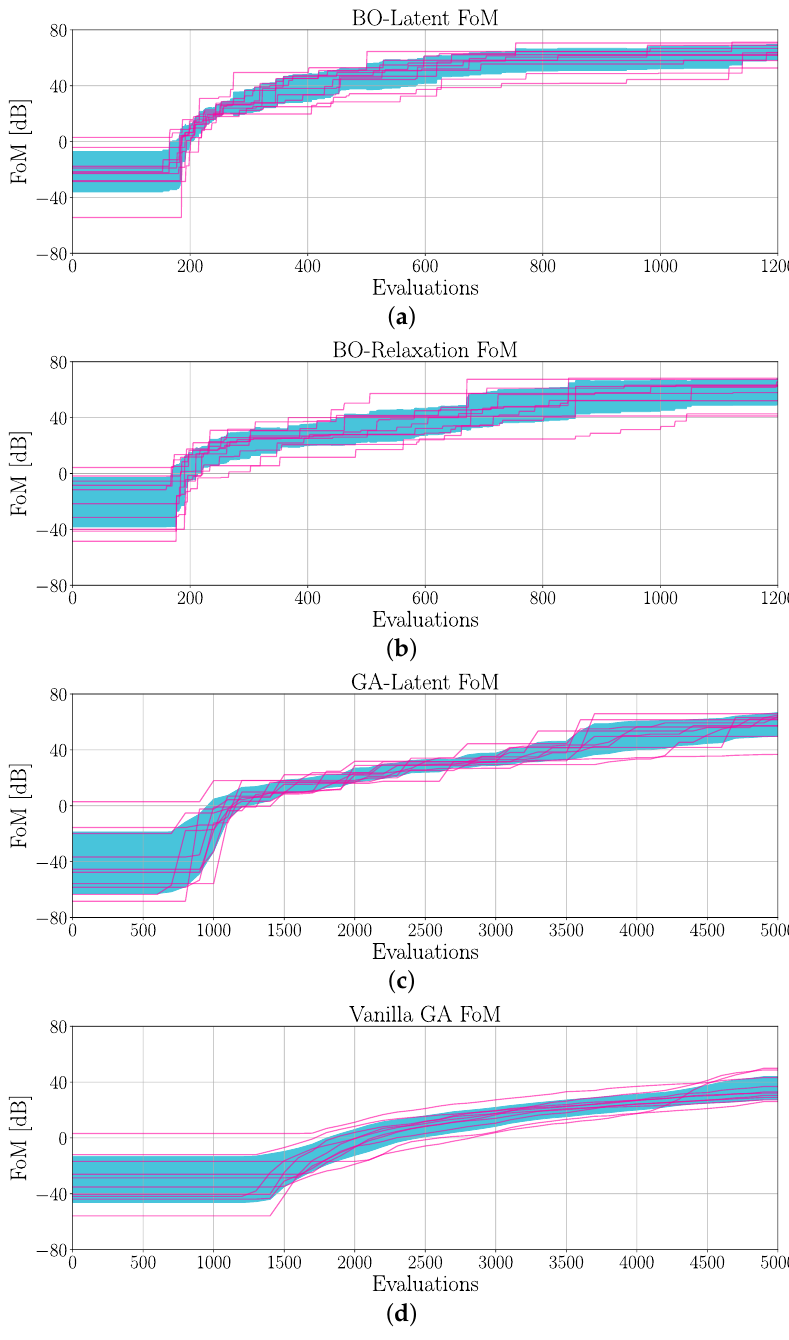
Figure 9. The evolution of the LNA’s FoM during the automatic sizing, using the four discussed formulations. The blue area indicates the confidence region of ± std, while the purple lines are the curves of each repetition. ( a ) BO-Latent. ( b ) BO-relaxation. ( c ) GA-latent. ( d )